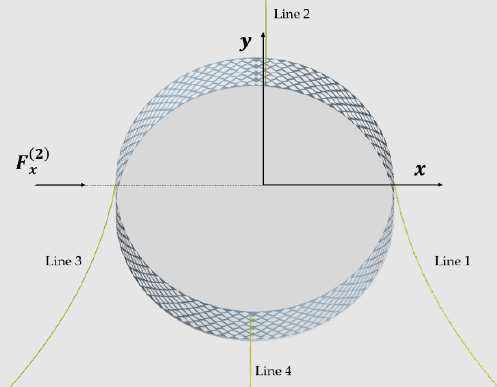
Figure 4. A 3D representation of the examined symmetric mooring system, composed by four identical mooring lines. Table 1. Mooring characteristics.